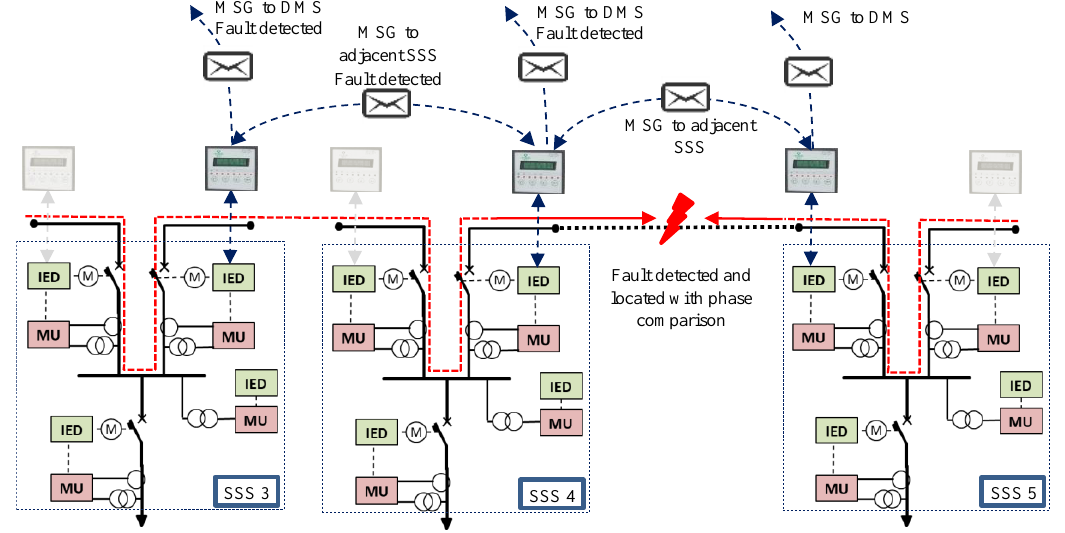
Figure 7. Short circuit current direction during three phase fault with meshed network.